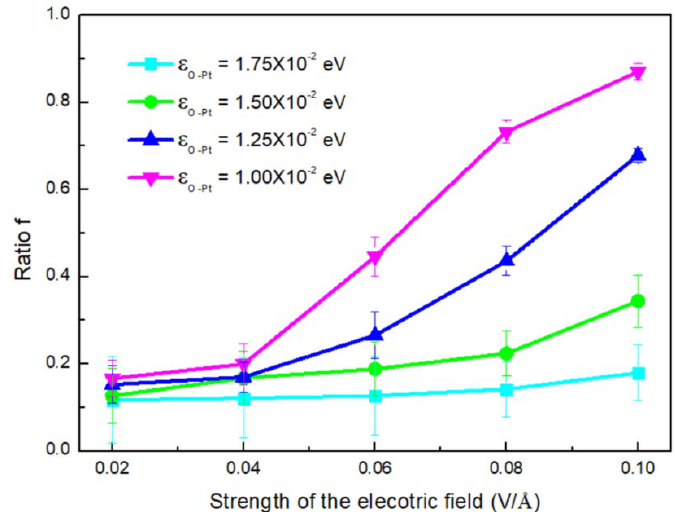
Figure 11. The ratio ( f ) varies with the strength of the electric field, where the deposition rate for the systems with and without electric field ( V ef ).